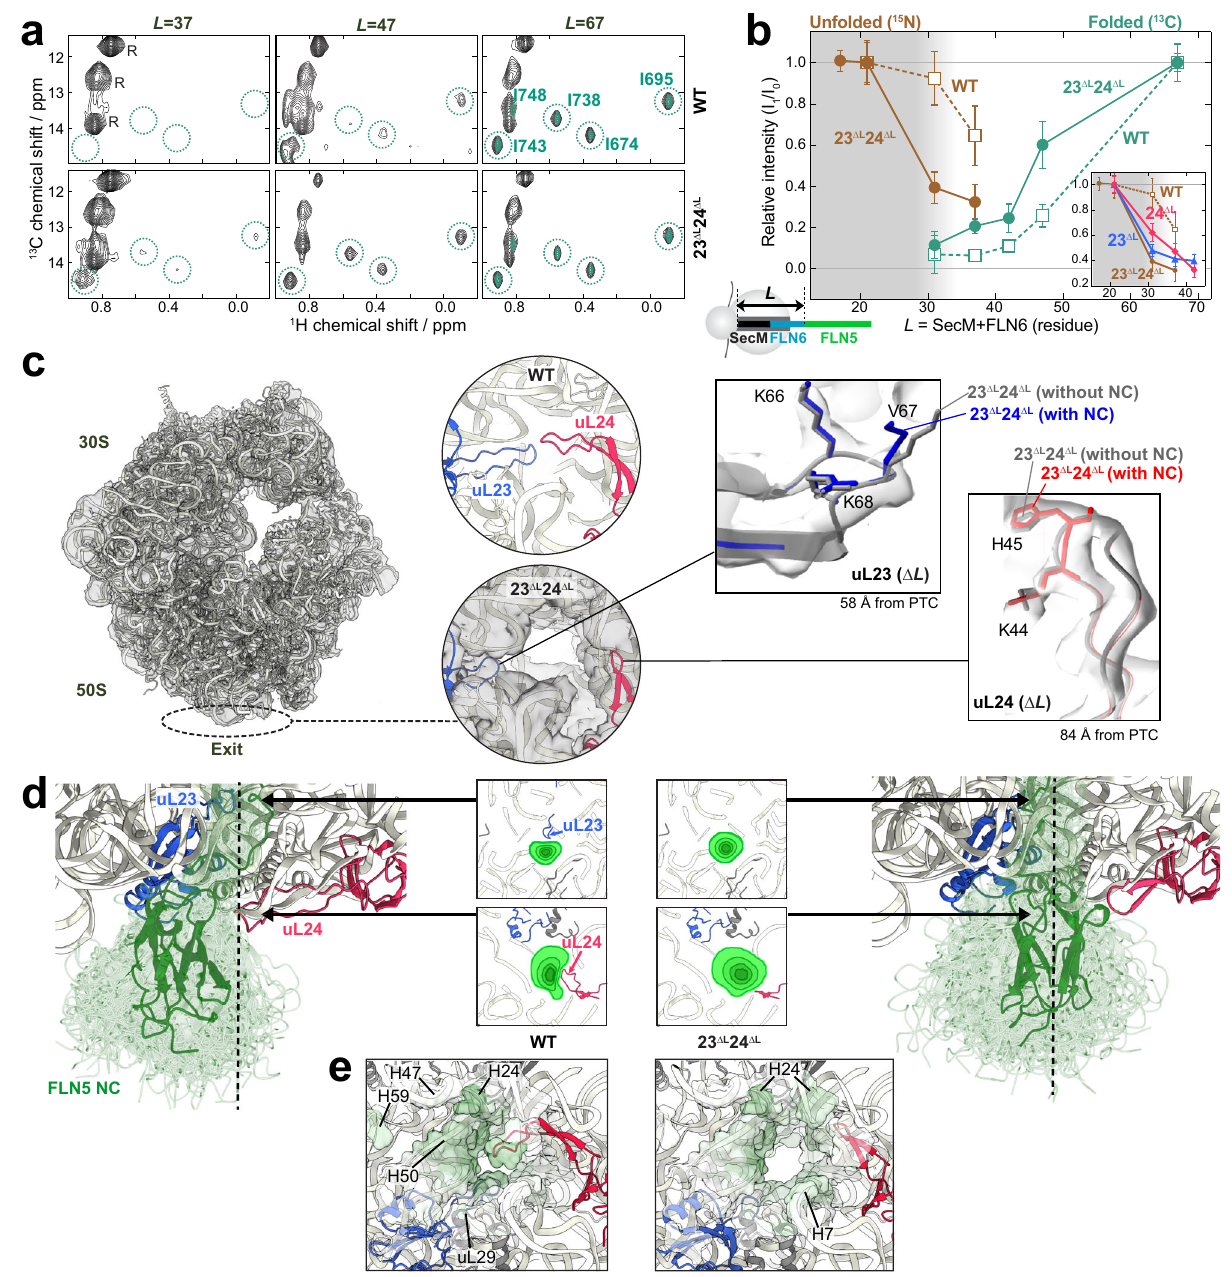
Fig. 3 The impact of the uL23 and uL24 loop truncation on the co-translational folding of FLN5. a 1 H- 13 C correlation spectra of folded FLN5 on WT and 23 Δ L 24 Δ L ribosomes ( L = 37 – 67). RNC spectra at L = 67 are overlaid with isolated FLN5 spectrum (turquoise, Supplementary Fig. 10). The Ile peaks corresponding to folded FLN5 used for intensity measurements in ( b ) (I674, I695, I738 and I743) are indicated by turquoise circles. b Changes in cross- peak relative intensities for three unfolded state peaks (from 15 N data, corresponding to V682, A683, A694, from Supplementary Fig. 7, brown) and four folded state peaks ( 13 C, from a turquoise) within FLN5 RNCs at different L . Shown are WT (open square, dotted line) and 23 Δ L 24 Δ L (closed circle, solid line) RNCs, respectively. Grey shading indicates the limits of the ribosome exit tunnel determined by PEG accessibility experiments 6 . (inset) relative intensities of 23 Δ L (blue triangle) and 24 Δ L (red diamond) RNCs. Errors are s.d. calculated by propagating the s.d. derived from the spectral noise of 13 C or 15 N spectra, respectively, and s.d. of nascent-chain concentrations from western blot replicates ( n = 3). c Cryo-EM map of the 23 Δ L 24 Δ L 70S ribosome. (circles) A magni fi ed view of the exit tunnel from the bottom of the WT (PDB:3JBU) and 23 Δ L 24 Δ L ribosome (empty ribosome cryo-EM density with the fi tted uL23 and uL24 structures). (rectangles) Local density of the truncated uL23 and uL24 loops are shown with the fi tted amino acids in the empty (grey) and translating (red and blue) ribosomes. d A structural ensemble of WT (left) and 23 Δ L 24 Δ L (right) RNCs at L = 37 derived from all-atom MD simulations, depicting the FLN5 NC as it is present both within and outside of the tunnel (Supplementary Fig. 8). The centre of the tunnel at the exit vestibule is shown with a black dashed line. (inset) Cross-sectional views of the tunnel showing the distribution arising from the ensemble of the folded state FLN5 ( L = 37 ) in the vicinity of the uL23 and uL24 tunnel loops ( e ) Ribosomal surface interaction with NC obtained from all-atom MD simulations. Interacting regions are coloured in